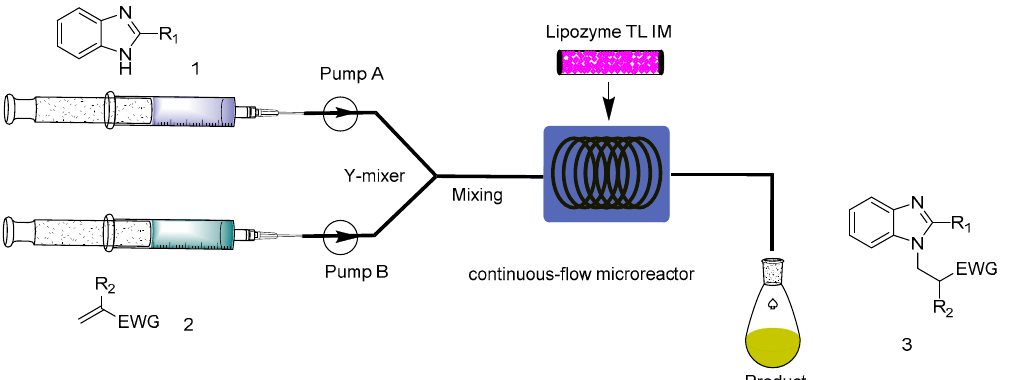
Figure 6. Equipment for the synthesis of N-substituted benzimidazole derivatives from benzimidazoles and α , β -unsaturated compounds catalyzed by Lipozyme TL IM from Thermomyces lanuginosus under continuous-flow microreactors.